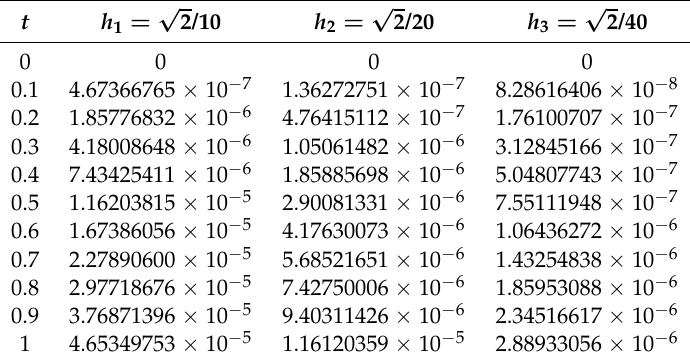
and α = 0.9 for Example 1000